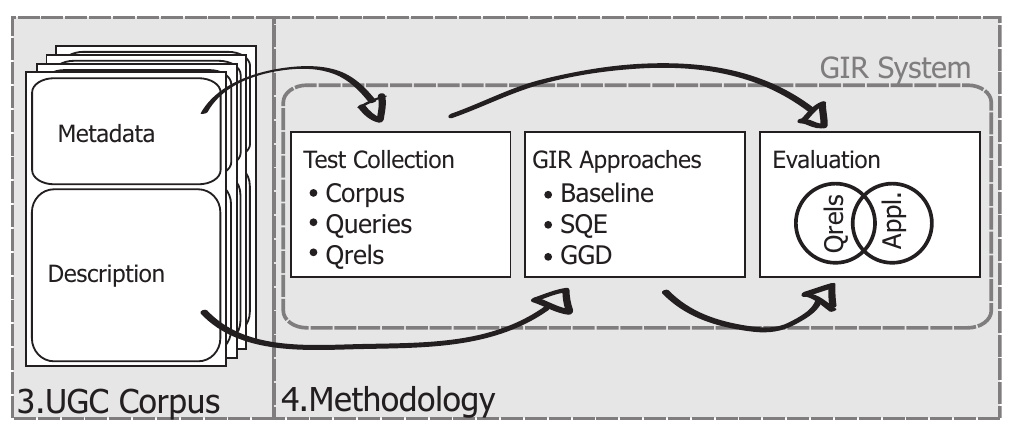
Figure 2: Overall framework of the experiments described in this